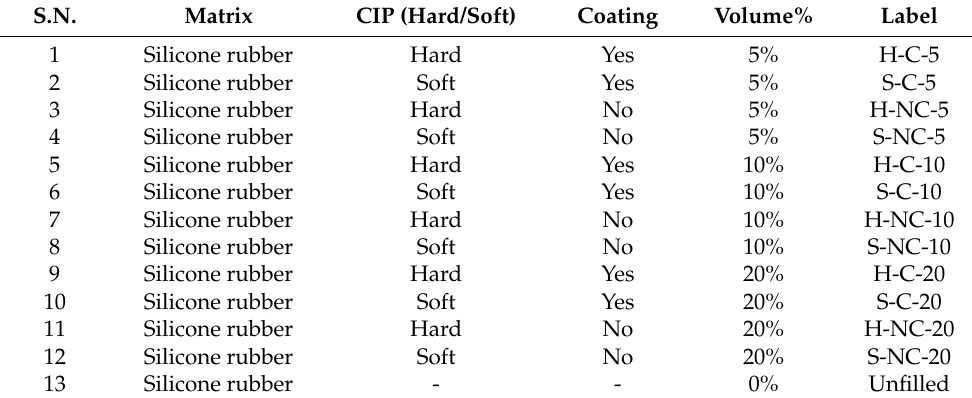
Table 3. Composition and labels of the fabricated